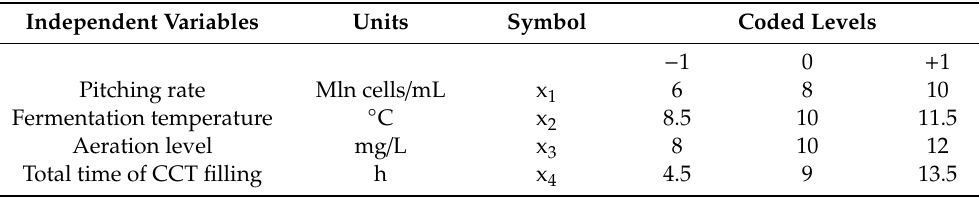
Table 1. Coded and actual values of the variables for the Box–Behenken design.